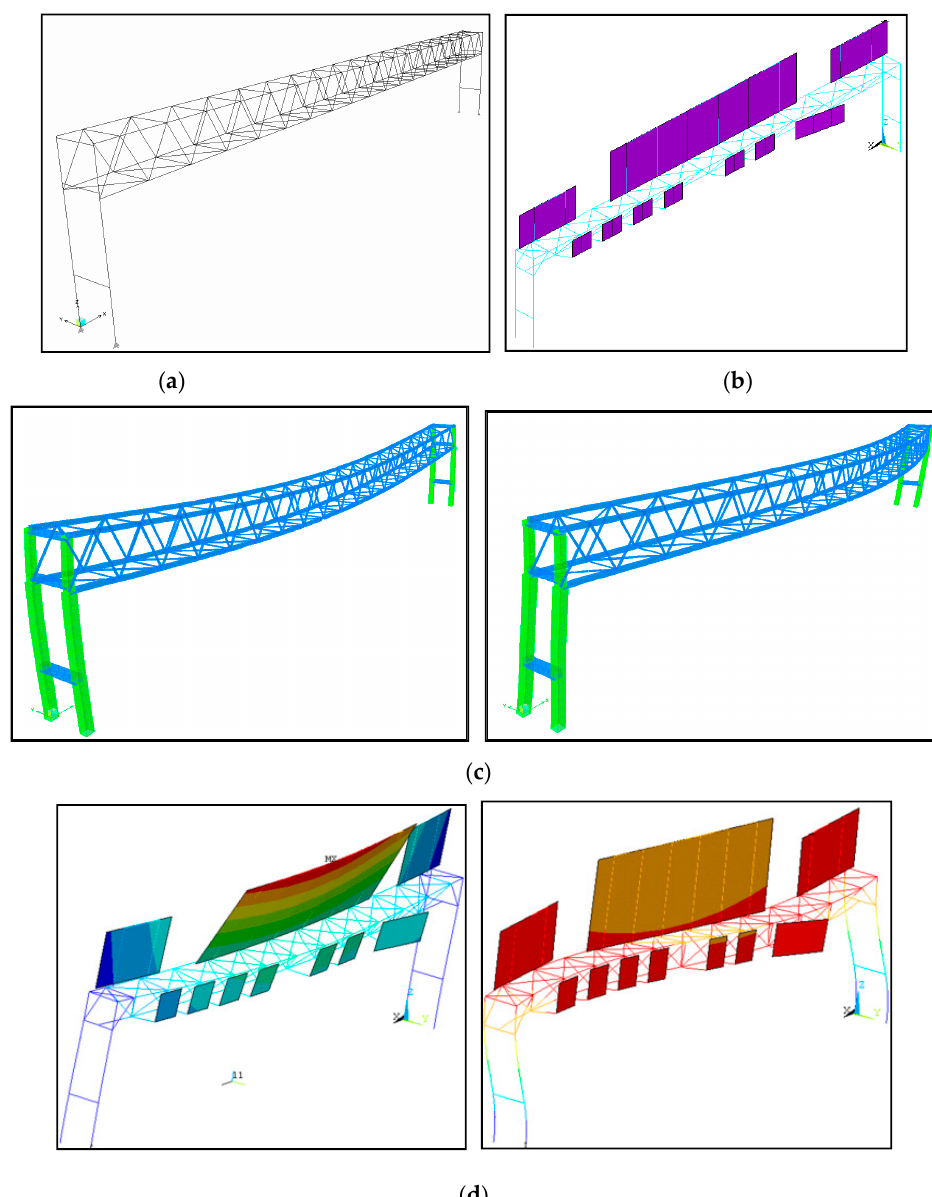
Figure 13. Global model of portal gantry ( a ) without and ( b ) with signs \ signal boxes, and ( c ) gantry mode shapes without dynamic effects of traffic signs and ( d ) with traffic signs